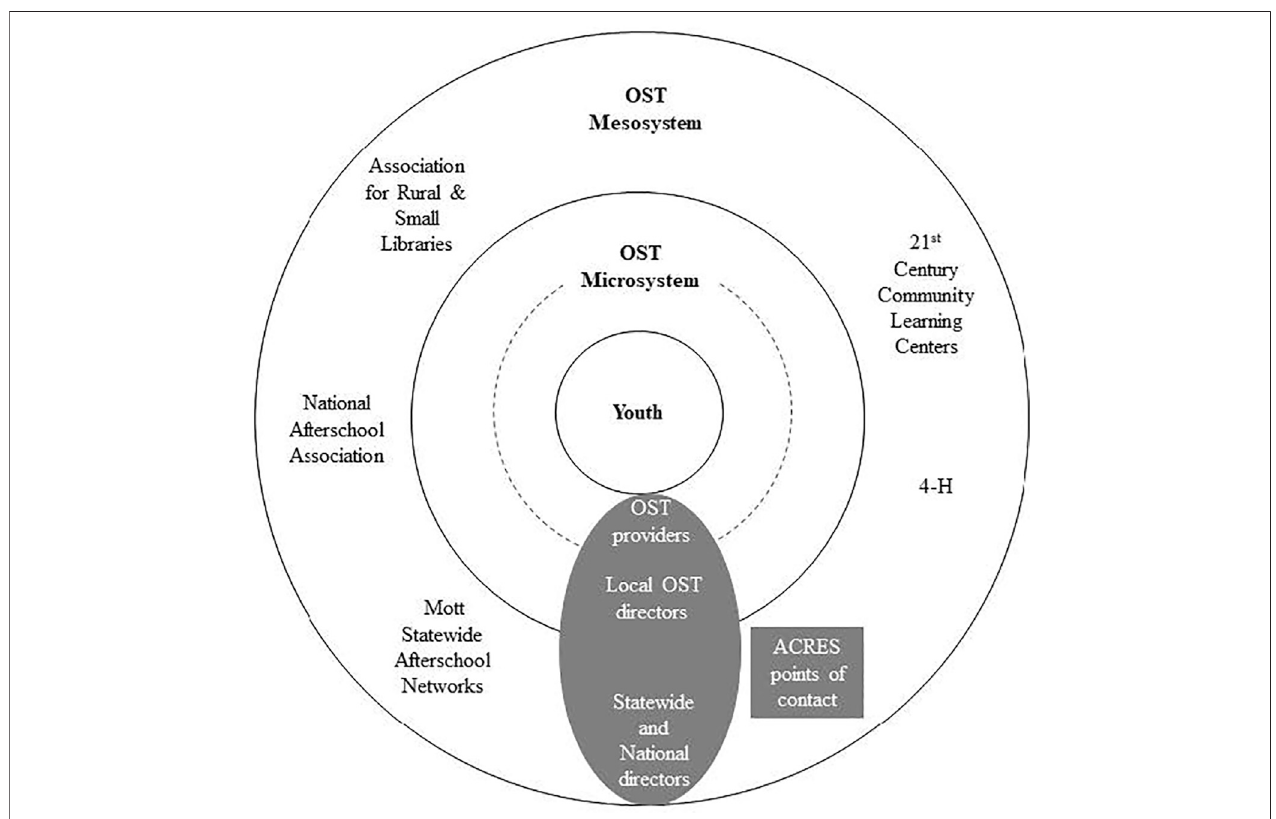
FIGURE 1 | Adaptation of Bronfenbrenner ’ s ecosystem model to show the OST contexts where ACRES has been implemented, and the levels at which ACRES interacts directly with stakeholders in the OST system.